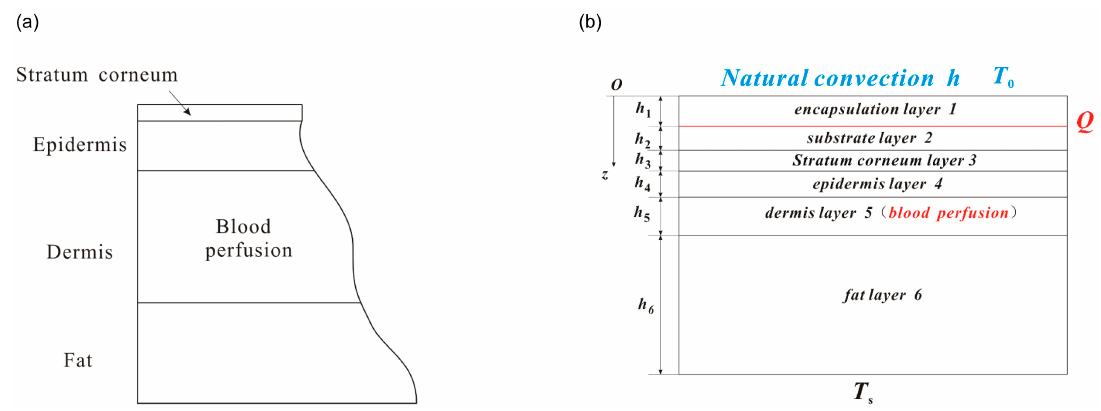
Figure 1. ( a ) Schematic illustration of the skin tissue structure; and ( b ) schematic illustration of one-dimensional geometry of the analytic modeled device-skin system.